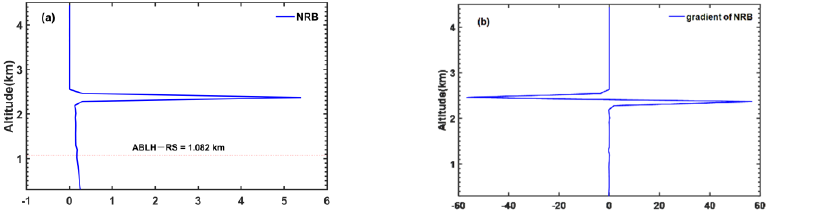
Figure 1. Vertical distributions of normalized relative LiDAR backscatter signal on typical cloud conditions: ( a ) one cloud layer is observed at 23:31UTC, 05 February 2003. Horizontal line with red color depicts the position of ABLH by RS; ( b ) NRB gradient; ( c ) relative increase in NRB.